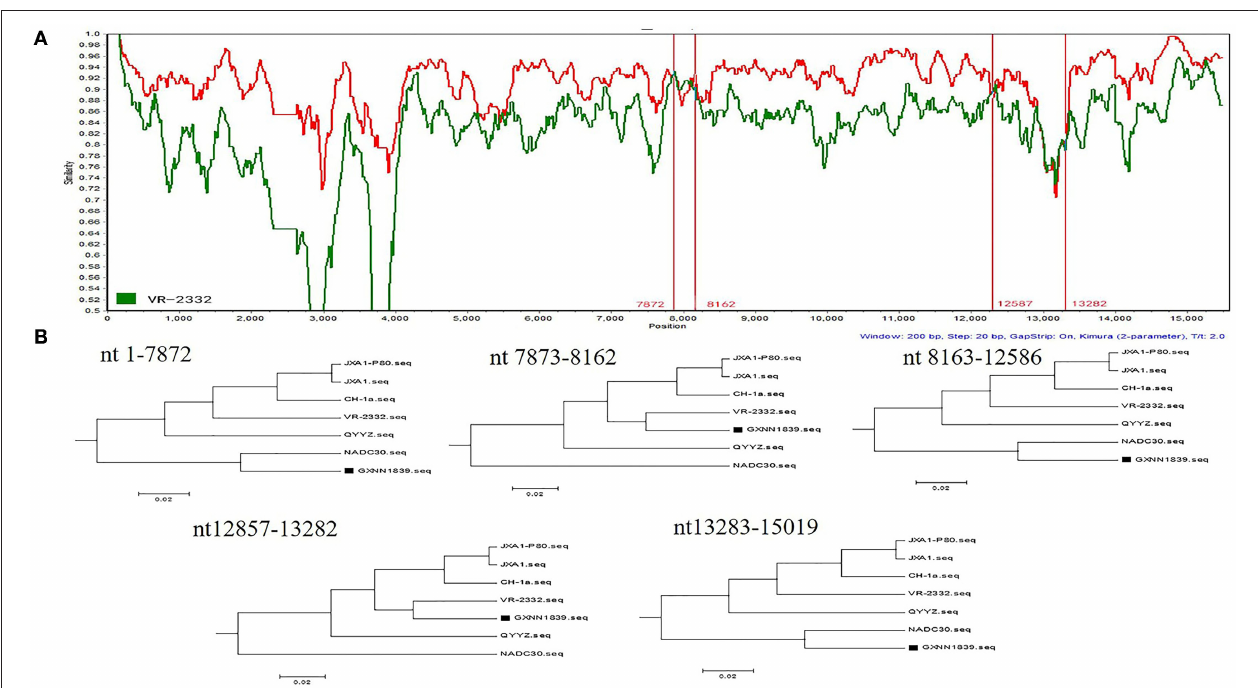
FIGURE 4 | Identification of potential recombination events in the genome of the GXNN1839 strain using RDP3.44. (A) Comparisons of genetic similarities between recombinant and parental strains were made by SimPlot. The complete genome of GXNN1839 was chosen as the query sequence. The y-axis indicates the percentage similarity between the parental sequences and the query sequence. The red real diagram indicates the recombination breakpoints. (B) Phylogenetic trees of different regions in the GXYL1403 genome were analyzed by RDP3.44 with UPGMA parsimony. Five trees were generated by the recombinant regions (position: nt7873–8162 and nt12857–13282) and the non-recombinant regions (position: nt1–7872, nt8163–12586, and